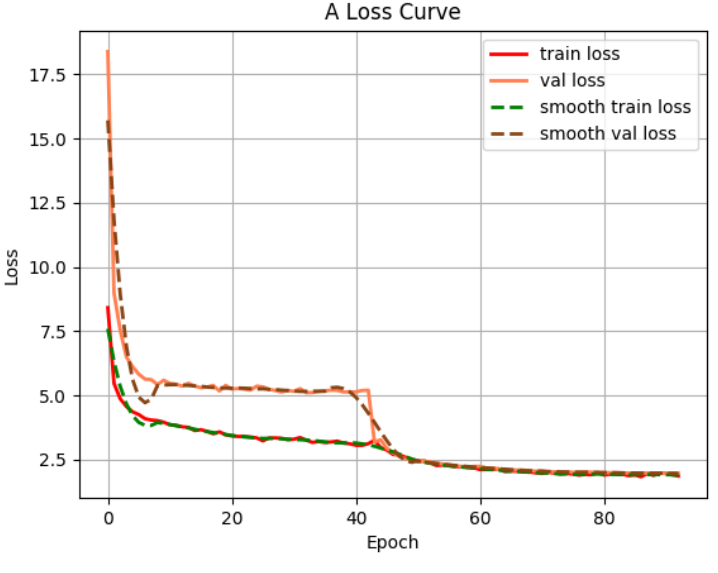
Figure 10. The loss